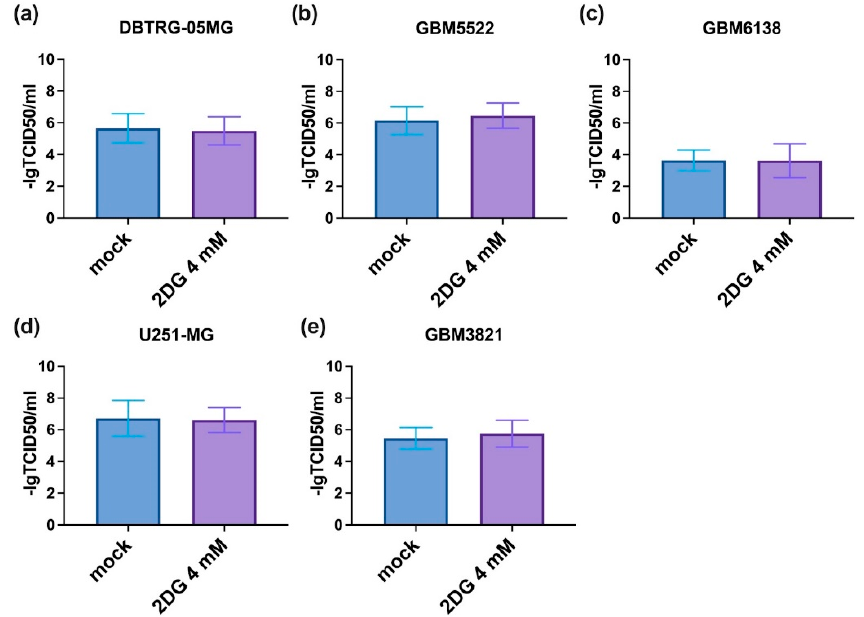
Figure 6. 2DG does not affect CVB5 replication. HEK293T cells were infected with the conditioned medium from DBTRG-05MG ( a ), GBM5522 ( b ), GBM6138 ( c ), U251-MG ( d ) or GBM3821 ( e ) glioblas- toma cells treated with 4 mM 2DG simultaneously with CVB5, harvested 48 h post-infection. Cell viability was assessed 72 h later using MTT assay. Values are means ±